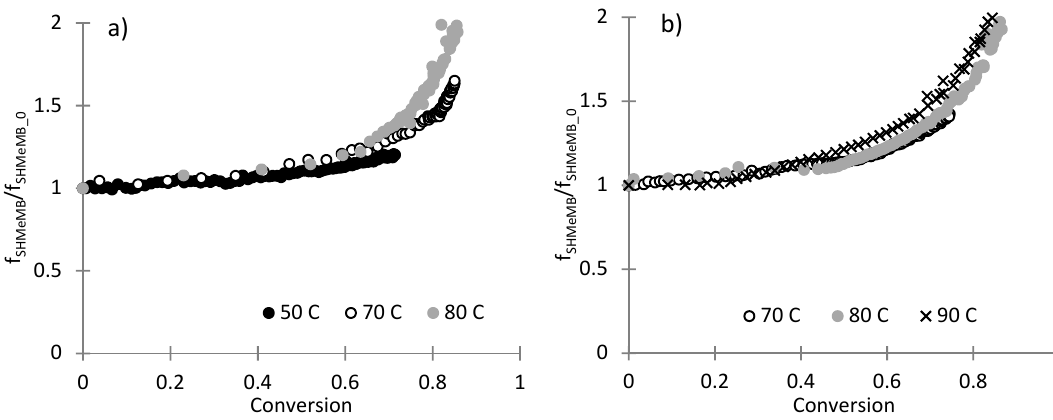
Figure 2. Monomer composition drift with conversion for copolymerization with an initial 3:7 SHMeMB:AM molar ratio, 15 wt % monomer and ( a ) 0.5 wt % V-50 initiator, or ( b ) 1.67 wt % V-86 initiator at varying temperatures (90 ◦ C experiment was conducted with 0.5 wt % V-86).